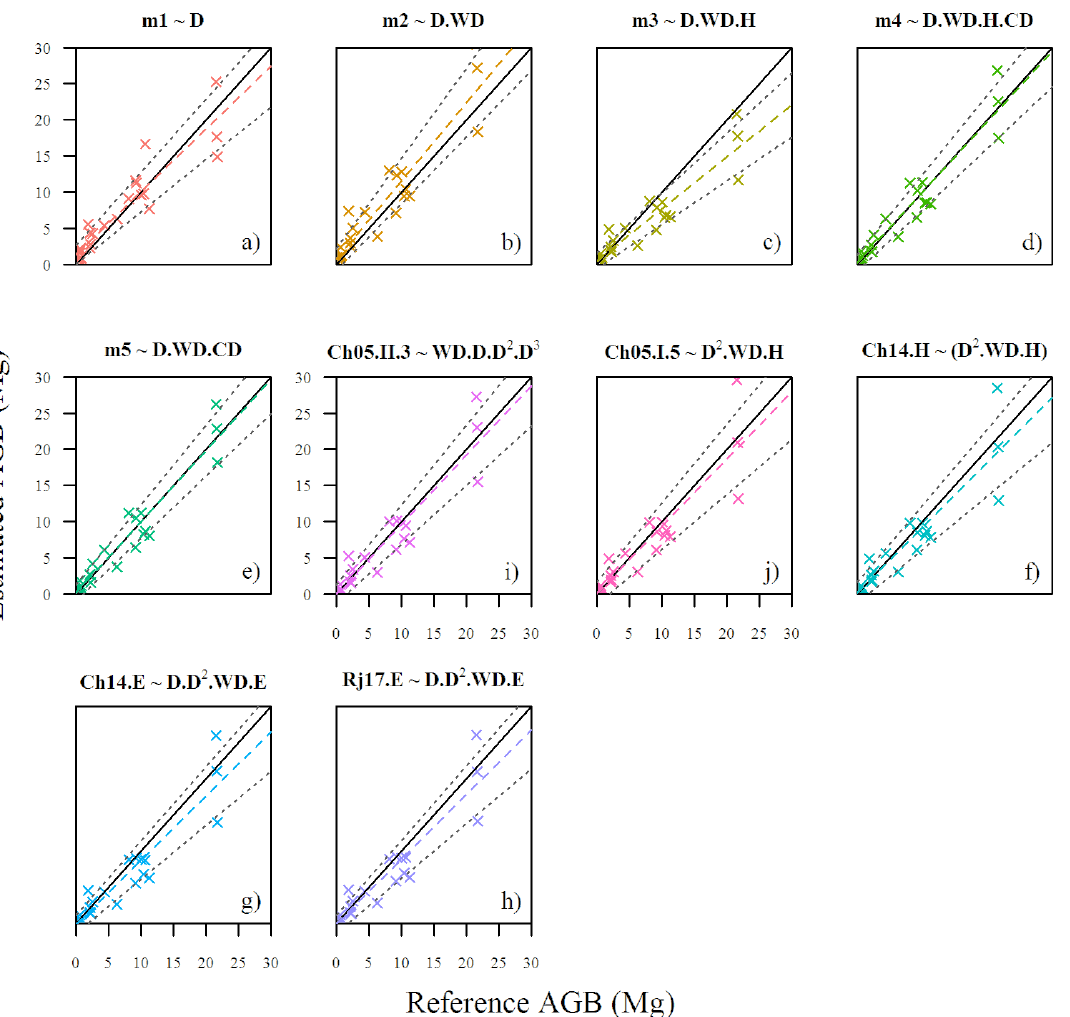
Figure 4. Relationship between reference AGB (harvested trees; n = 26) and AGB estimated by TLS-derived and pantropical allometric models. Black solid line is 1:1 relationship; dashed coloured lines depict linear fit; and dotted grey lines indicate 95% confidence interval for the linear